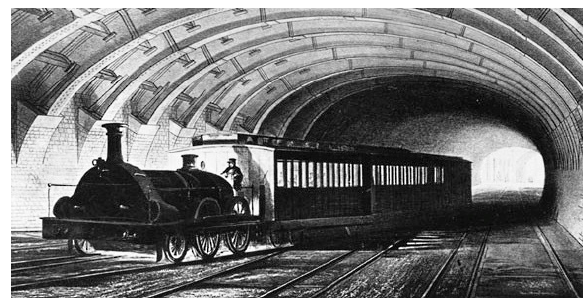
Figure 1. Historic subsurface tunnels of the London Underground [3]